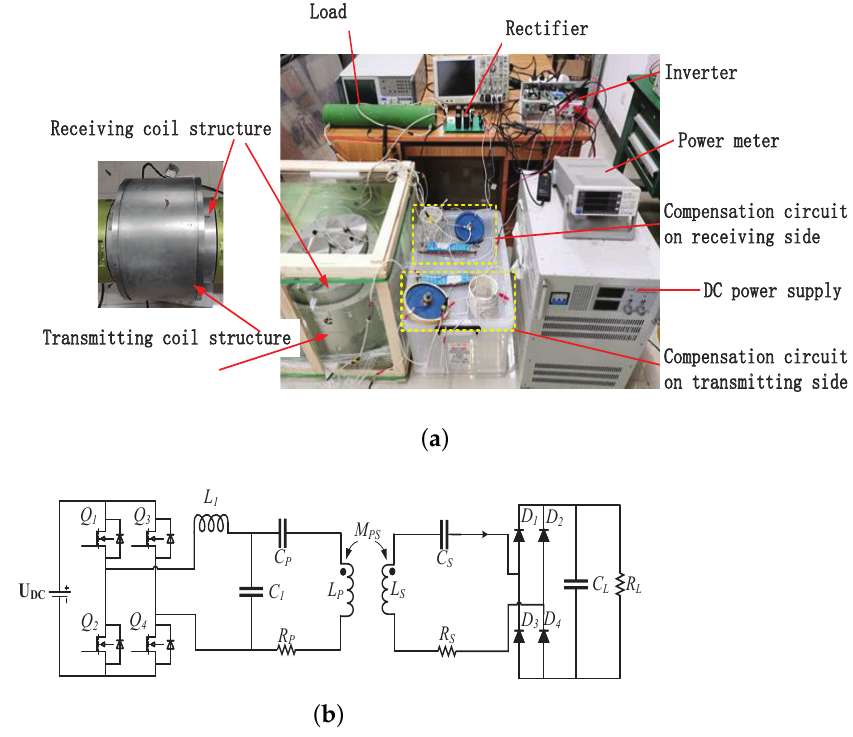
Figure 6. ( a ) Picture of the prototype. ( b ) Schematic diagram of LCC-S-compensated topology. Table 2. Parameters of the prototype.